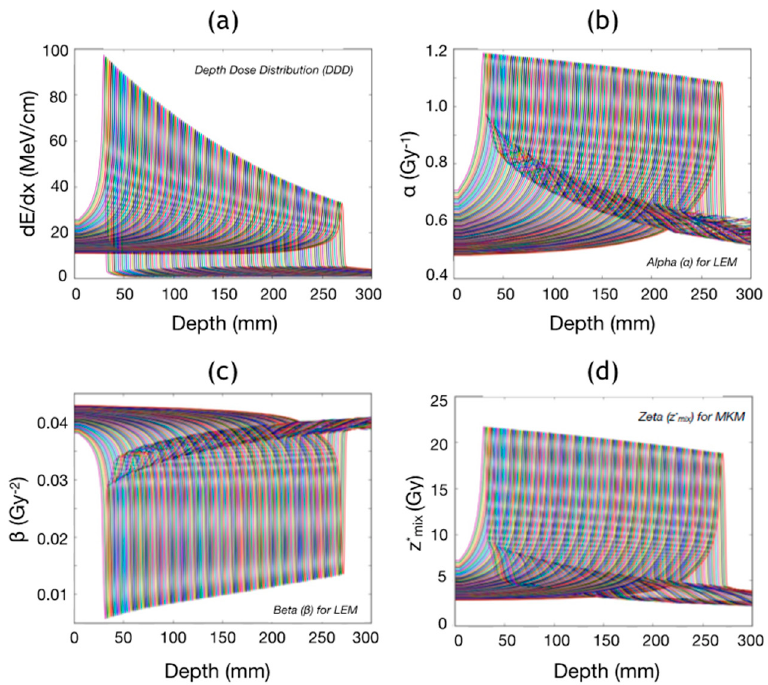
Figure 7. CNAO carbon ion depth-dependent database for all beam energies: ( a ) depth-dose distribution, ( b ) alpha for LEM, ( c ) beta for LEM, and ( d ) z* mix for MKM.